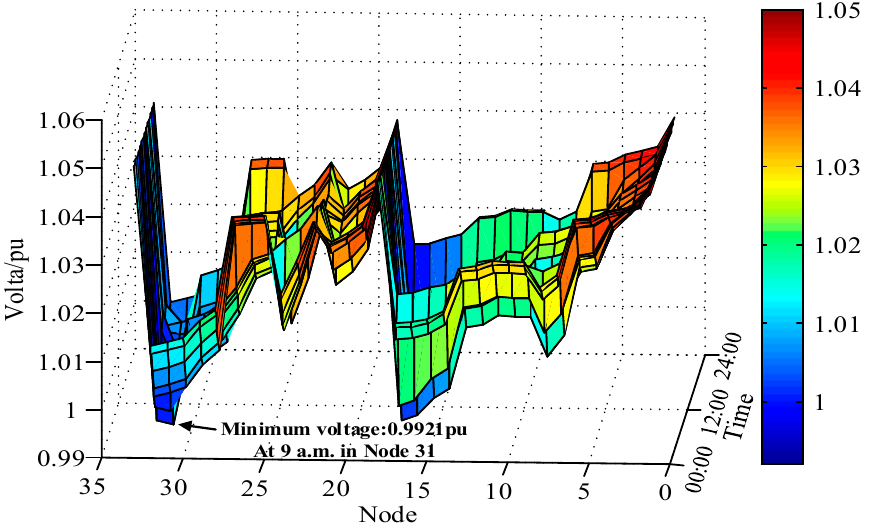
Figure 7. Voltage distribution in the distribution network.